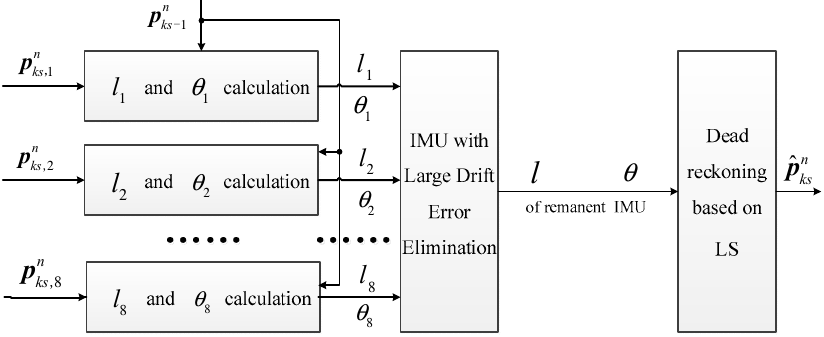
Figure 3. Position estimated method by adaptive dead reckoning. represents the horizontal position estimated in the ( ks −